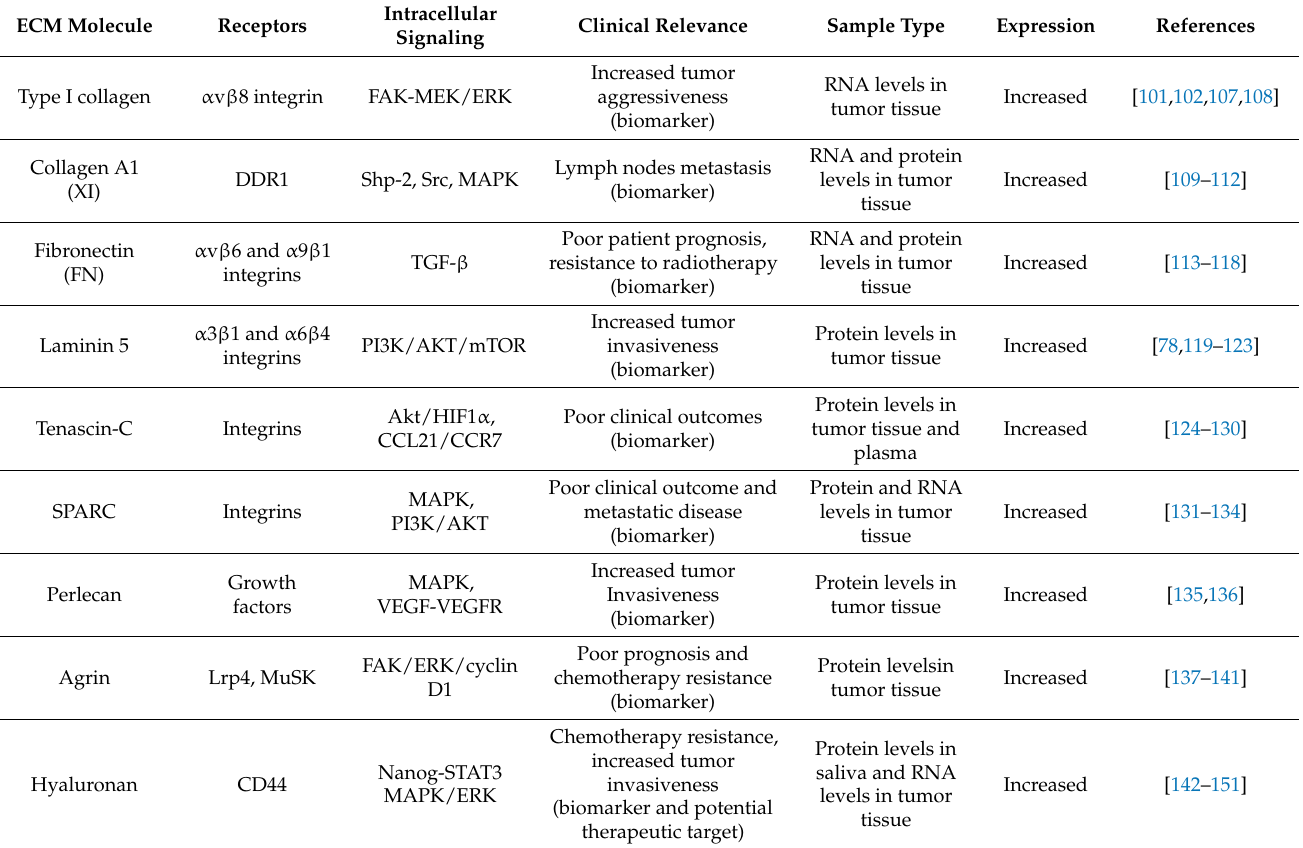
Table 1. Main ECM molecules involved in UADT SCC and their roles in tumor